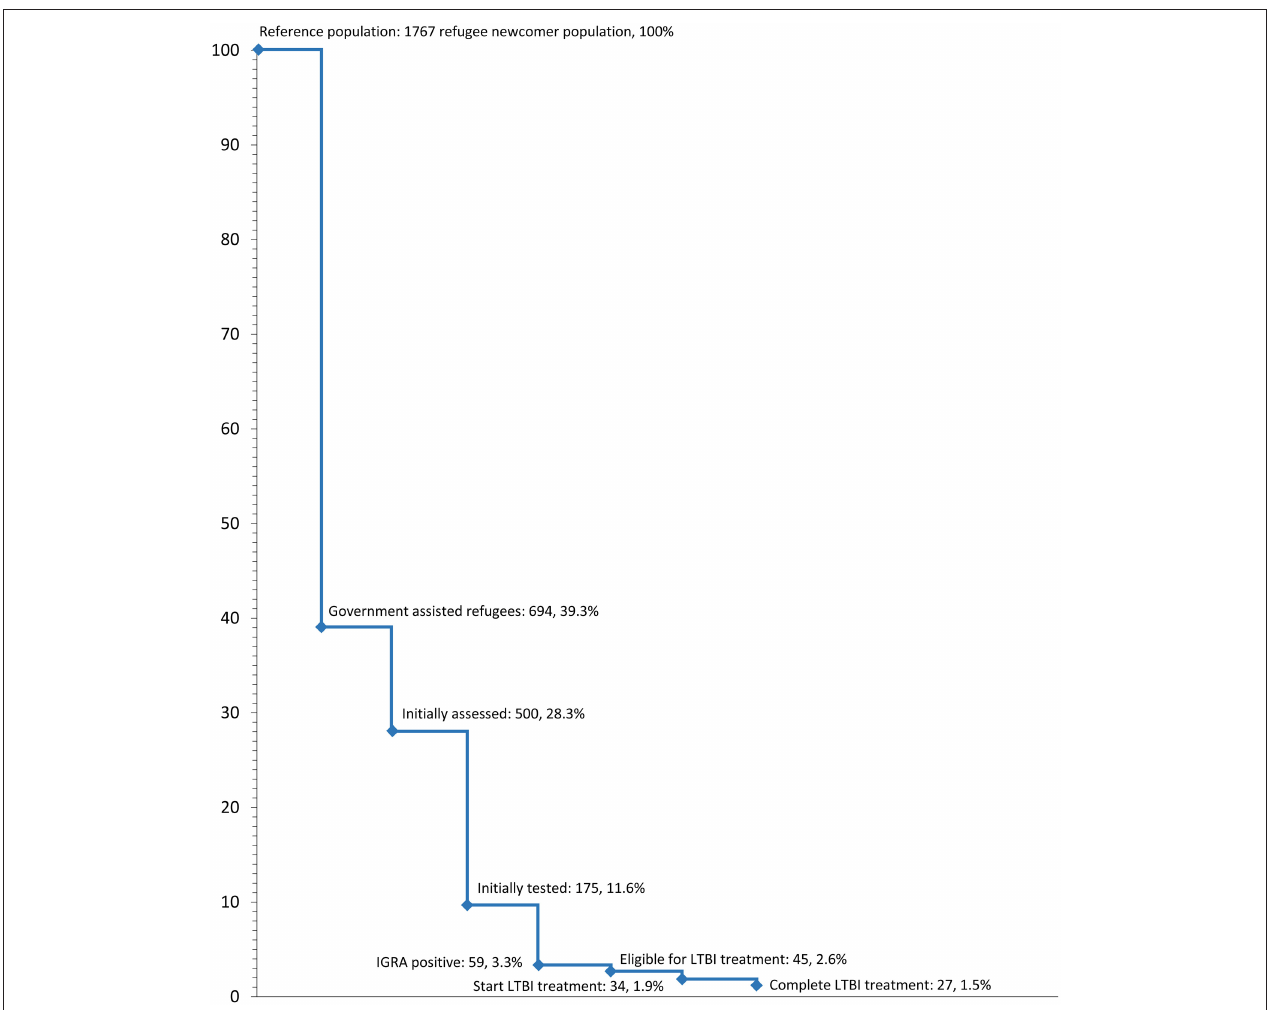
FIGURE 1 | Losses in the cascade of latent tuberculosis infection care in refugee clients at BridgeCare Clinic with positive IGRA and eligible for